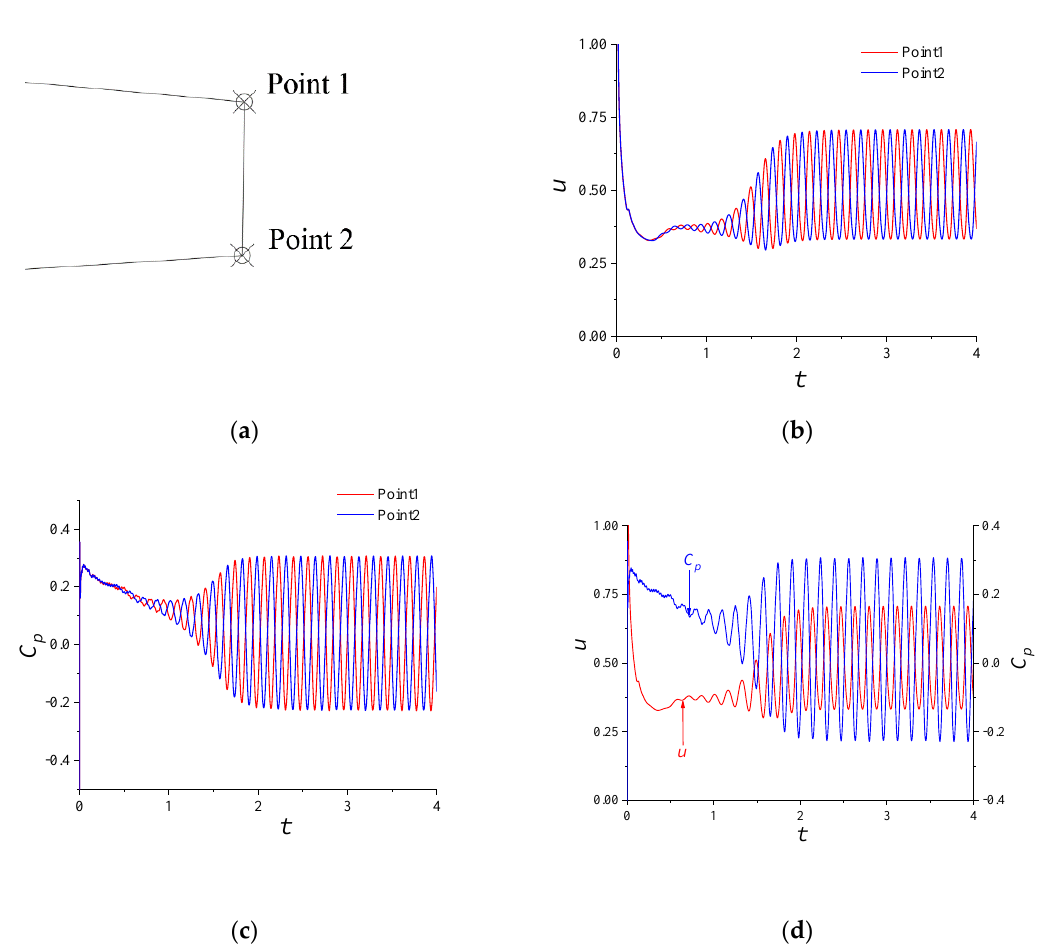
Figure 9. Velocity and pressure variations at the trailing edge of the hydrofoil. ( a ) Positions of the monitoring points. ( b ) Velocity variations at the two monitoring points. ( c ) Pressure changes at the two monitoring points. ( d ) Relationship between velocity and pressure at Point 1. J. Mar. Sci. Eng. 2020 , 8 , x FOR PEER REVIEW